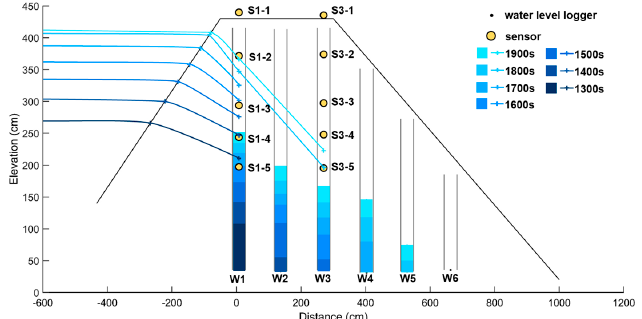
Figure 11. Analysis of seepage using water level data from the water gauge and monitoring data from the sensors in the earth dam seepage test. from the sensors in the earth dam seepage